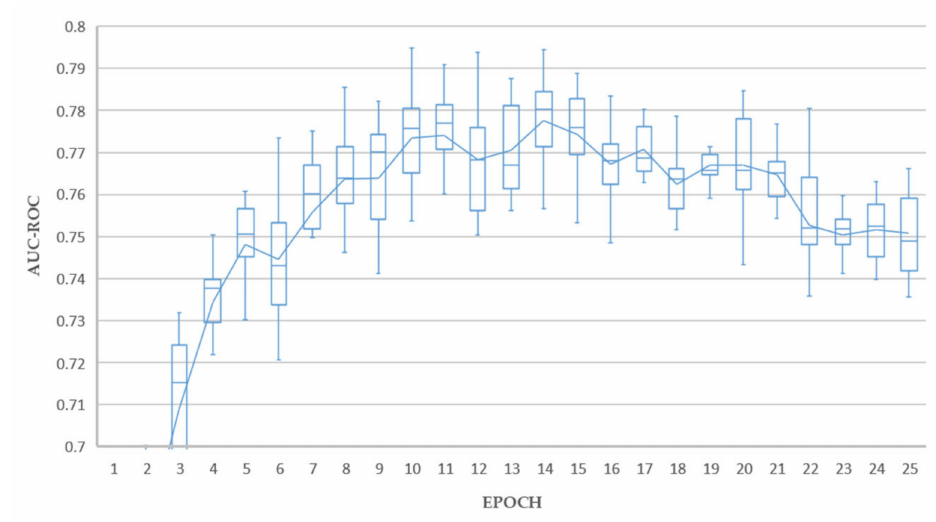
Figure 7. Average AUC-ROC for 10 rounds of holdout testing (Test